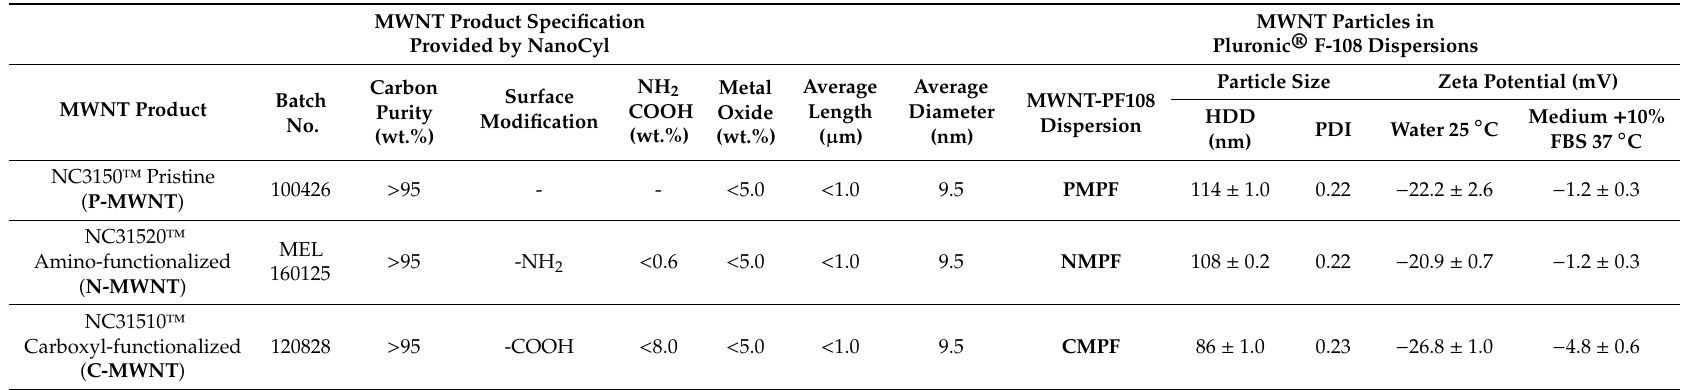
F108-coated MWNT